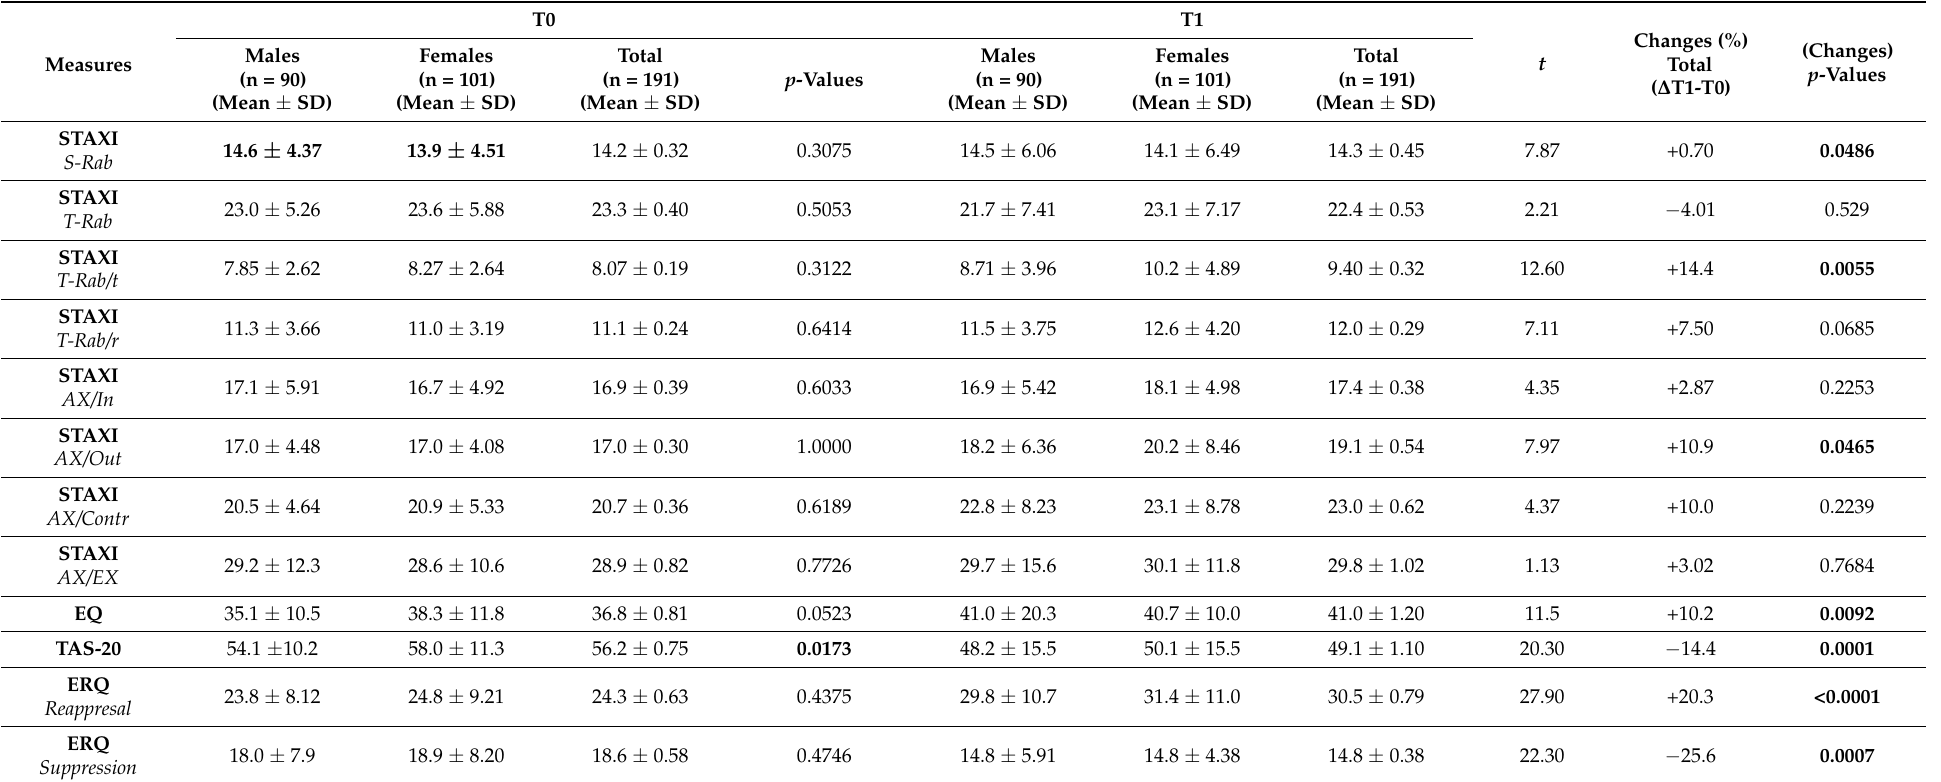
Table 1. Differences in psychological dimensions before (T0) and after the psychoeducational intervention